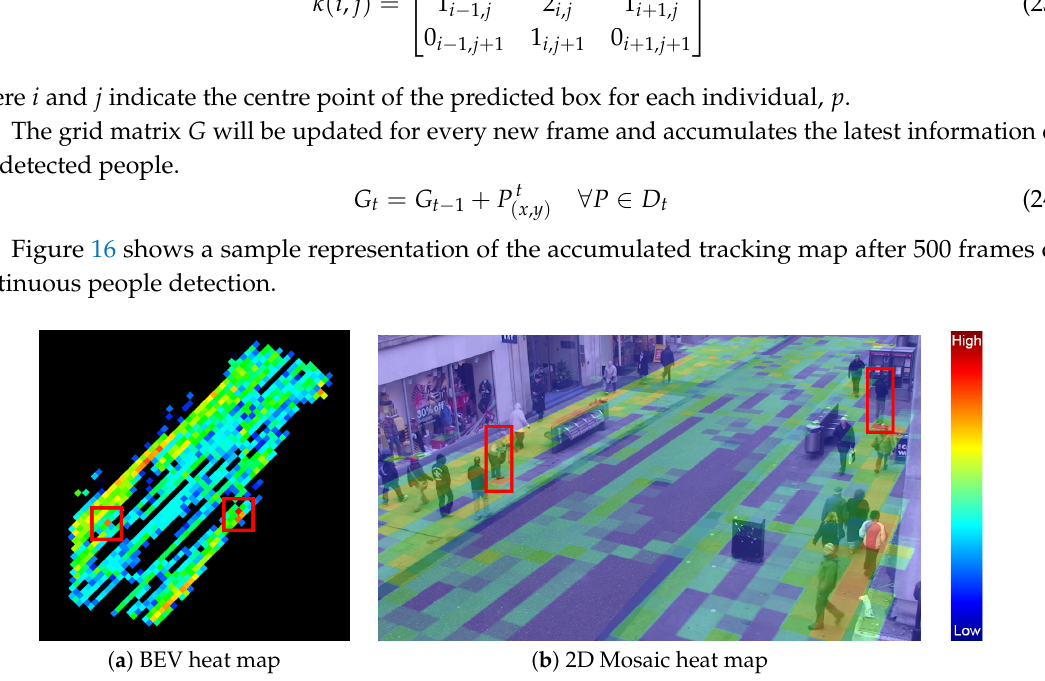
Figure 16. Accumulated tracking maps after 500 frames. Blue: low-risk, Red: